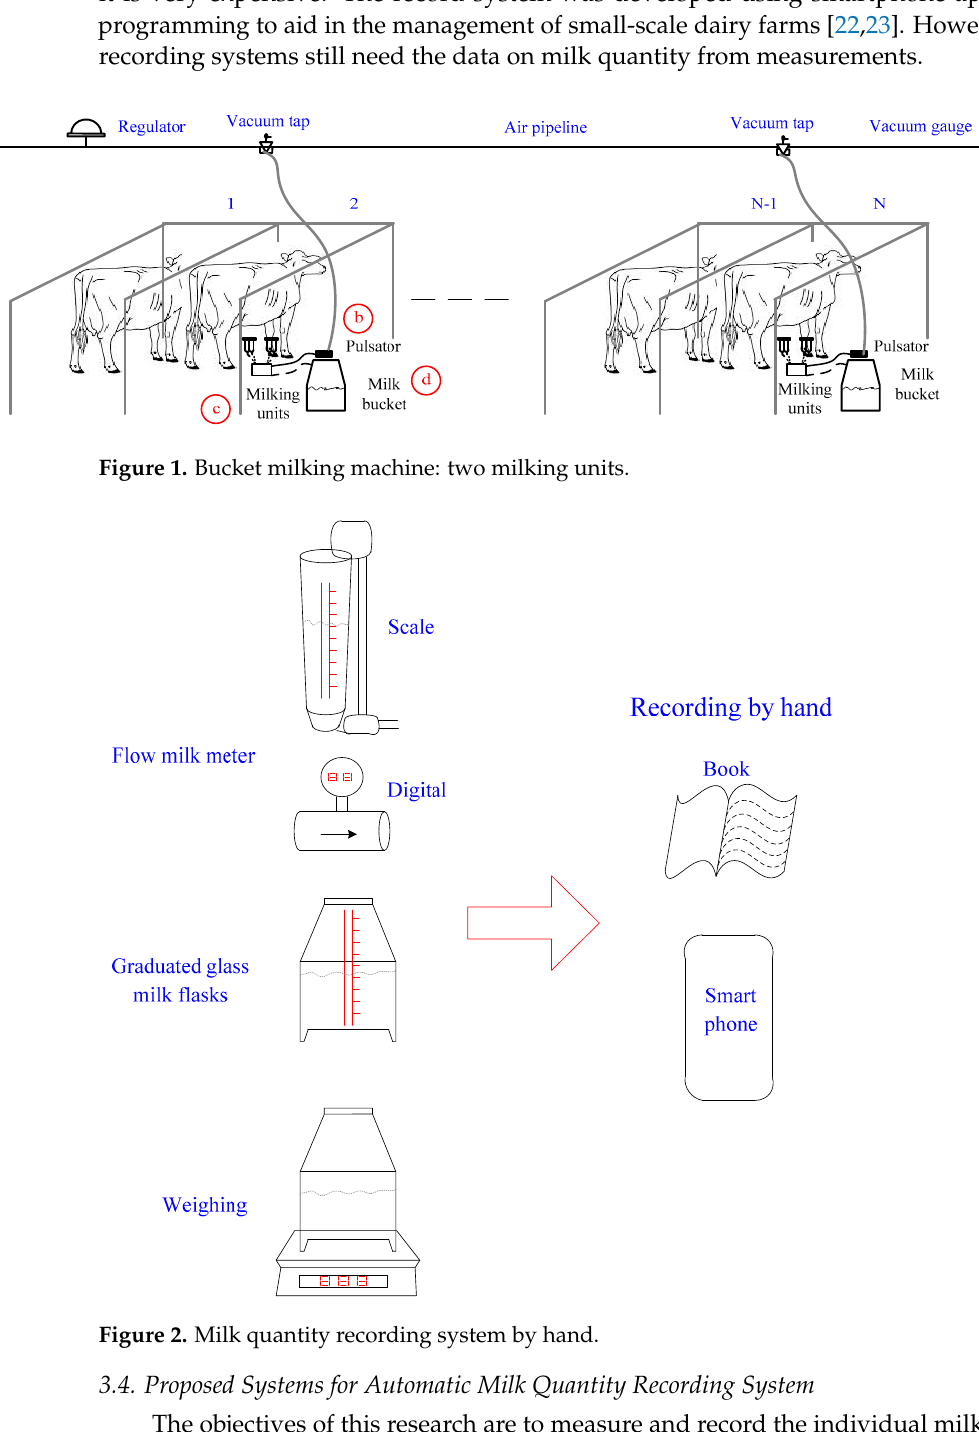
Figure 3. Proposed system.